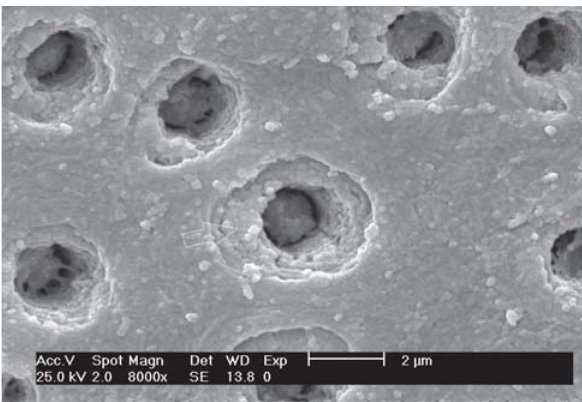
FIGURE 9- SEM micrograph of group 4 (Clearfil SE Bond) - Lateral view of the dentinal tubules. Observe the dentin surface free of smear layer and opened dentinal tubules (x8,000)